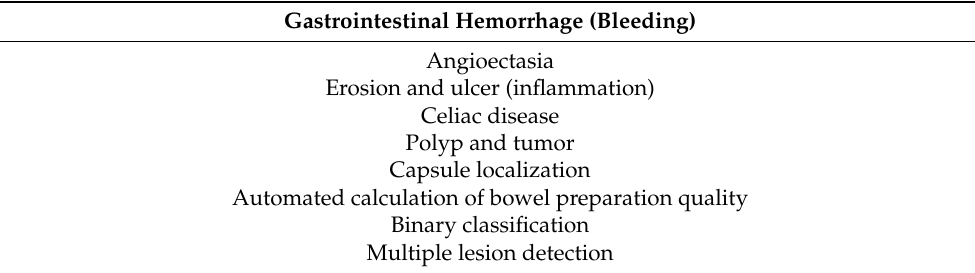
Table 1. Research fields of deep learning-based methods for capsule